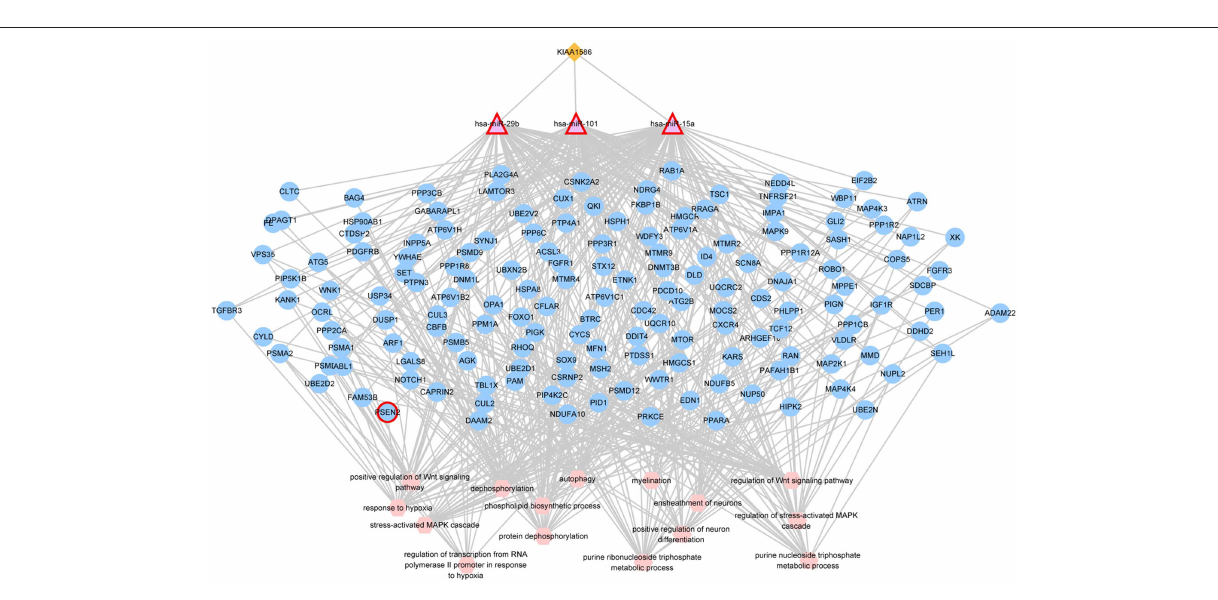
Frontiers in Bioengineering and Biotechnology |